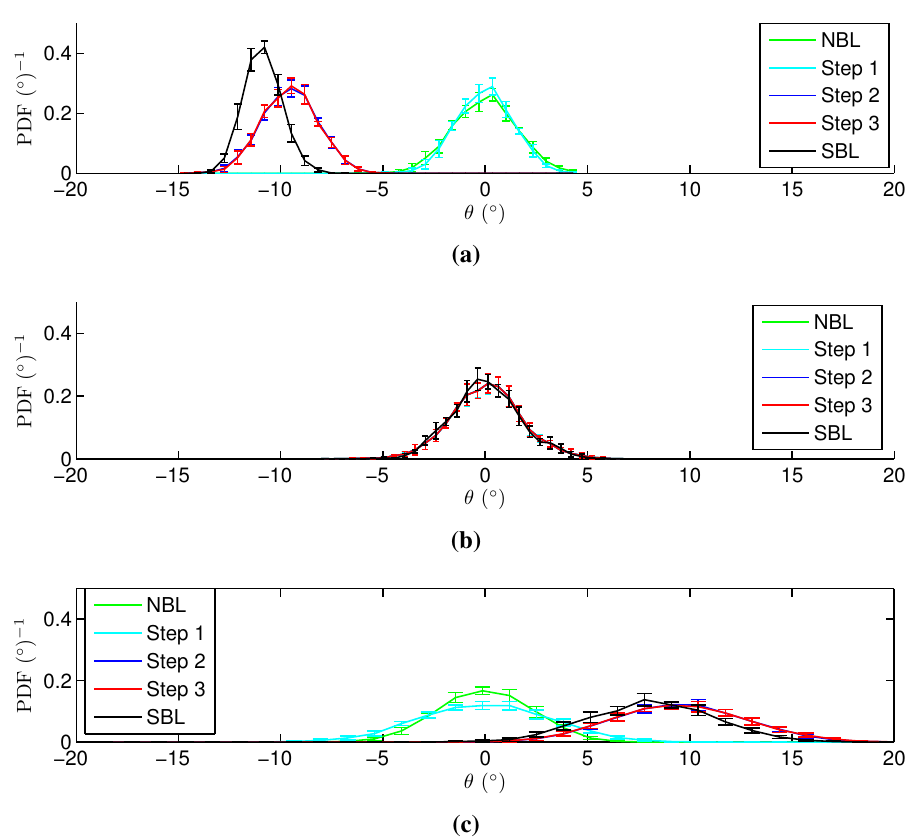
Figure 20. Probability density functions for the wind direction, θ , for a single case (control). ( a ) Rotor top; ( b ) Rotor hub; ( c ) Rotor